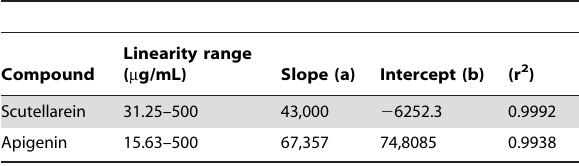
Table 2. Linearity parameters for the calibration curve of scutellarein and apigenin.